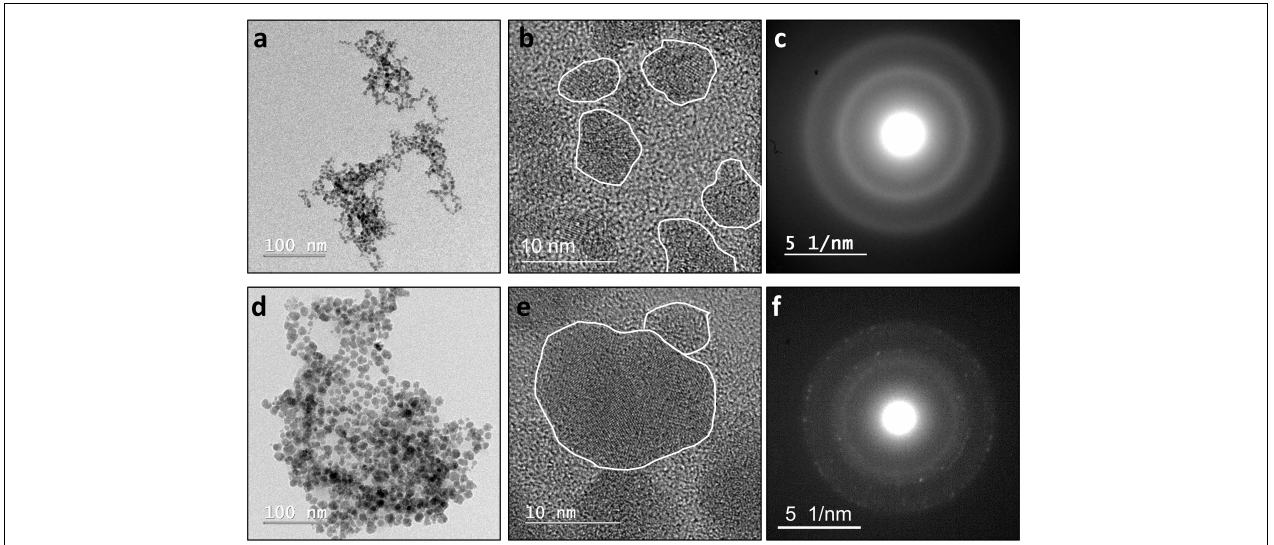
FIGURE 2 | Left to right: low resolution images, high resolution images and SADPs derived from the spheroidal nanoparticles. Top row (a–c) : spheroidal nanoparticles observed in abiotic “No Fe” systems during the early periods of incubation ( ≤ 1 week old). These nanoparticles are polyphasic, in that they display crystalline nano-domains ∼ 1–3 nm in size within an amorphous matrix. The corresponding SADP displays only diffuse rings. Bottom row (d–f) : spheroidal nanoparticles typically observed in the biotic “No Fe” systems. These nanoparticles are larger in size and are more crystalline. Similar nanoparticles are also observed in the abiotic “No Fe” systems after aging for > 1 week. The corresponding SADP starts to resolve into distinct spots with a set of d-spacing values that are most consistent with those of millerite. Annotated SADPs are available in Supplementary Material